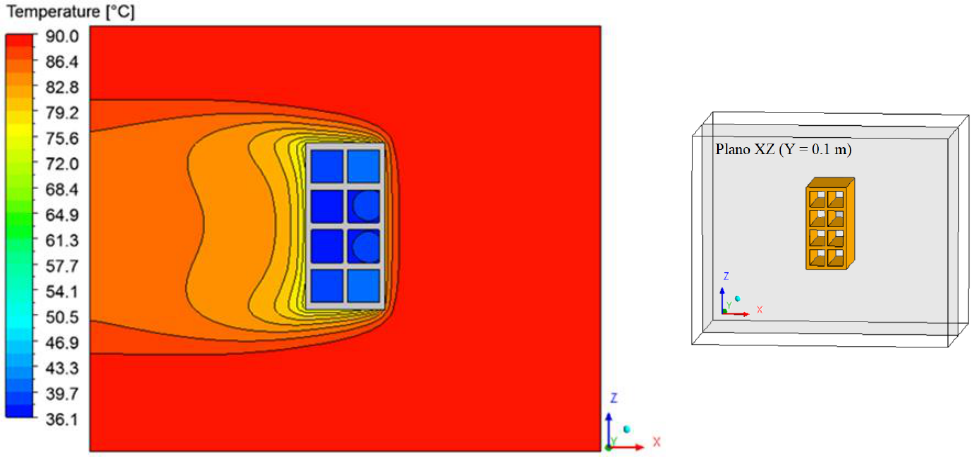
Figure 16. Air temperature distribution inside the oven (Plane XZ) for drying at 90 °C (t = 60 min).